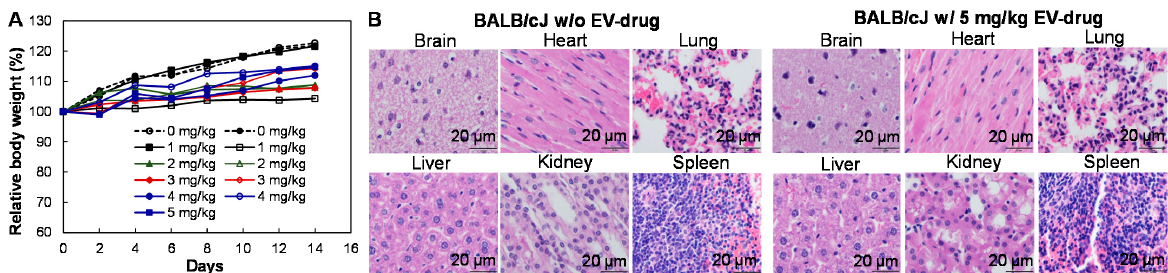
Figure 5. Tolerated dosage (TD) and toxicity analysis of mAb-EV-Ver-A. ( A ) Body weight change of non-GBM carrying BALB/cJ mice after treatment with five dosages of mAb-EV-Ver-A, including 0 ( ● , ○ ), 1 ( ■ , □ ), 2 ( ▲ , ∆ ), 3 ( ♦ , ◊ ), 4 ( ● , ○ ), and 5 ( ■ ) mg/kg ( n = 2). ( B ) H&E staining of main organs, including the brain, heart, lung, liver, kidney, and spleen. Scale bar equals 20